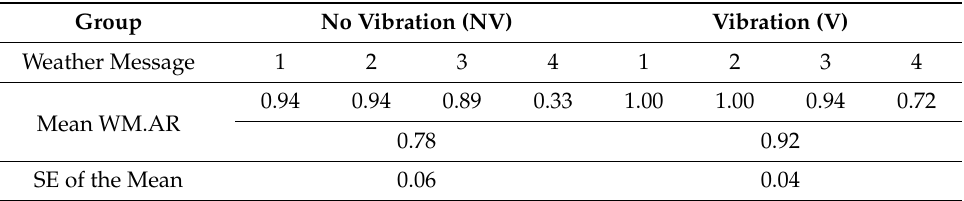
Mean weather message acknowledgement rate (WM.AR), divided by group and message number. Group No Vibration (NV) Vibration (V) Weather Message 1 2 3 Mean WM.AR SE of the Mean 0.06